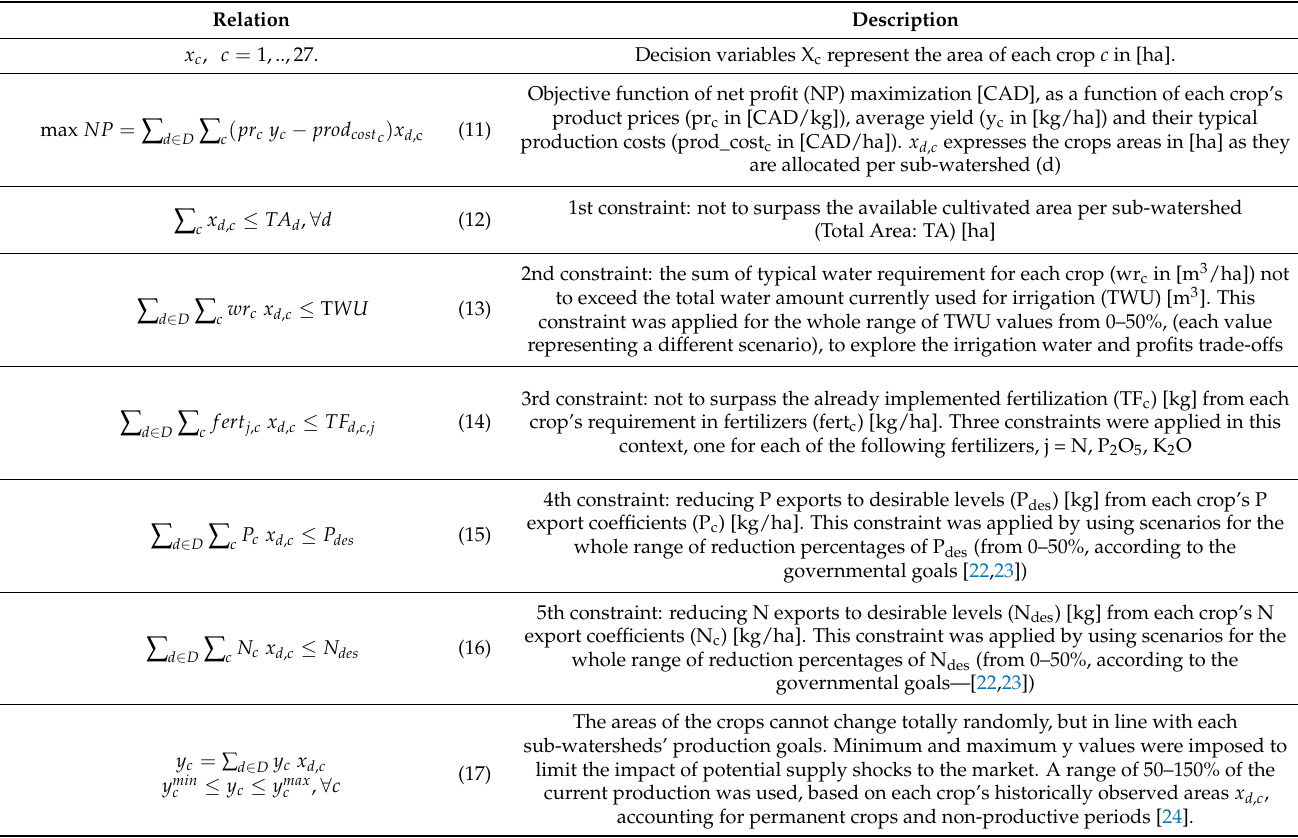
Table 2. Mathematical description of the NLEB model (annual values): 1 st Version. Relation